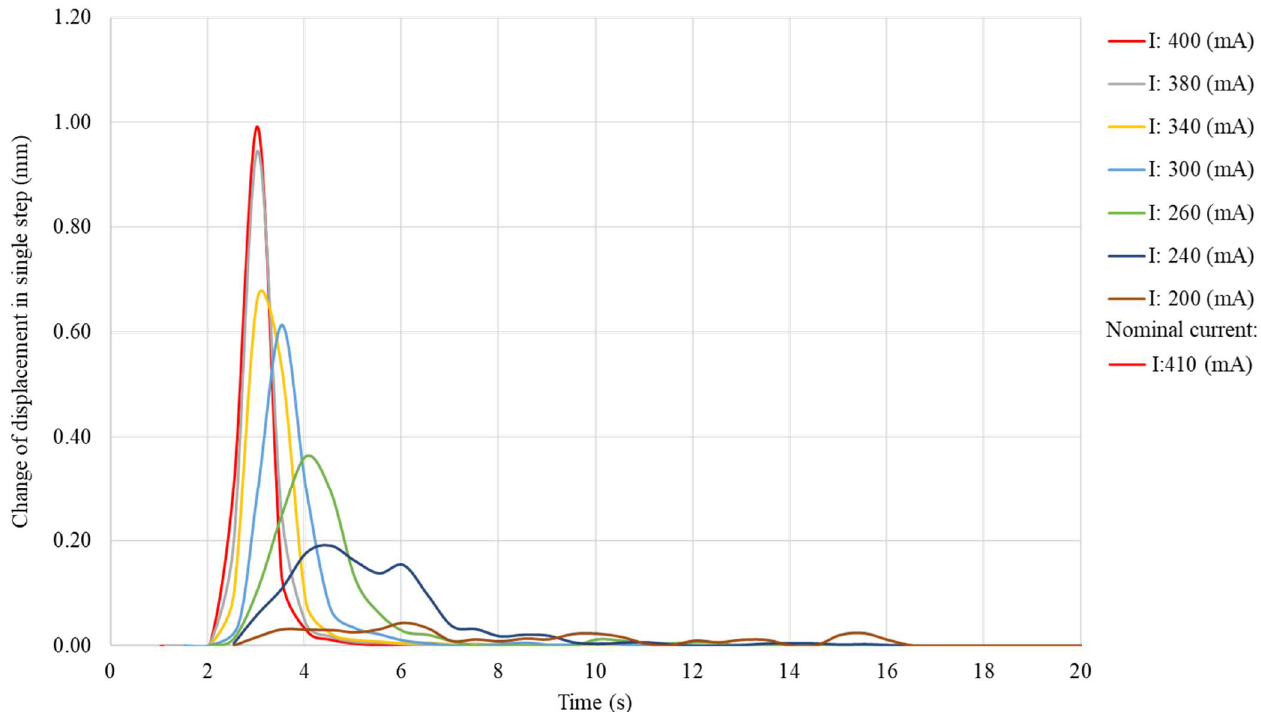
Figure 14. Change of the displacement in a single step of a 150 μm -diameter sample at different heating currents.